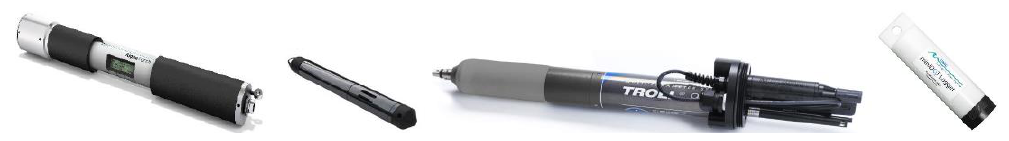
Figure 2. Examples of water quality sensors used in this research.